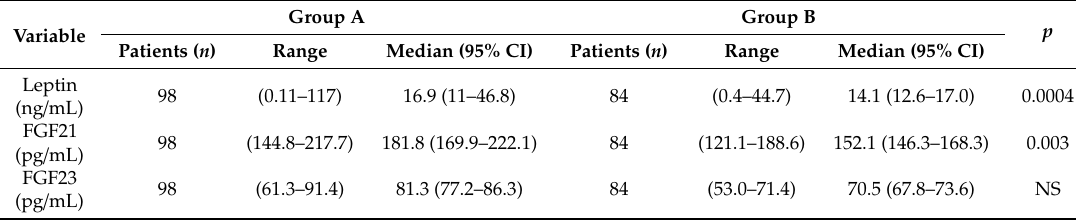
Table 4. Concentration distribution of examined proteins in endometrium cancer and control group.